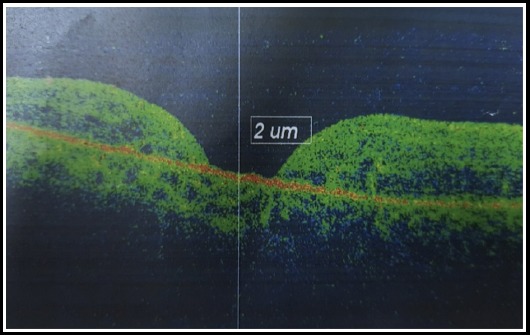
Type 2 macular hole closure.